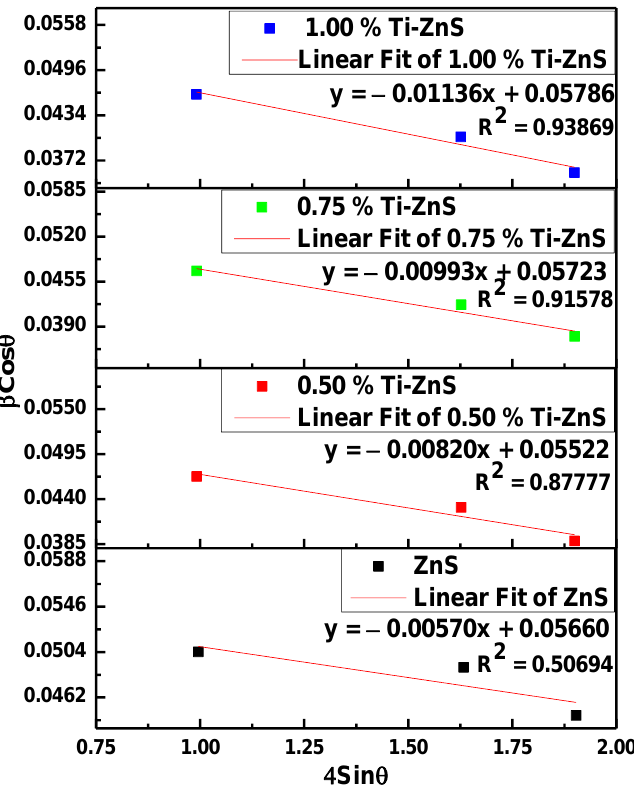
Figure 2. Williamson – Hall plot of undoped ZnS and Ti-doped ZnS nanopowder samples at different concentrations.